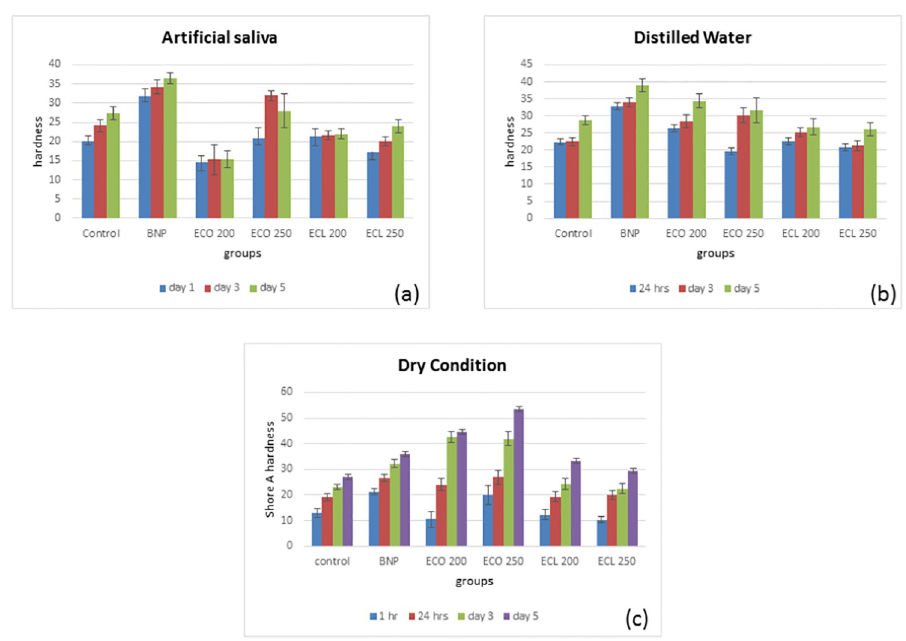
Fig 6. Mean Shore A hardness of control and experimental TC discs over 5 days in (a) artificial saliva, (b) distilled water and (c) dry conditions. It was found that the hardness values were high compared to the wet mode, whereby a non-significant difference was found between the distilled water and artificial